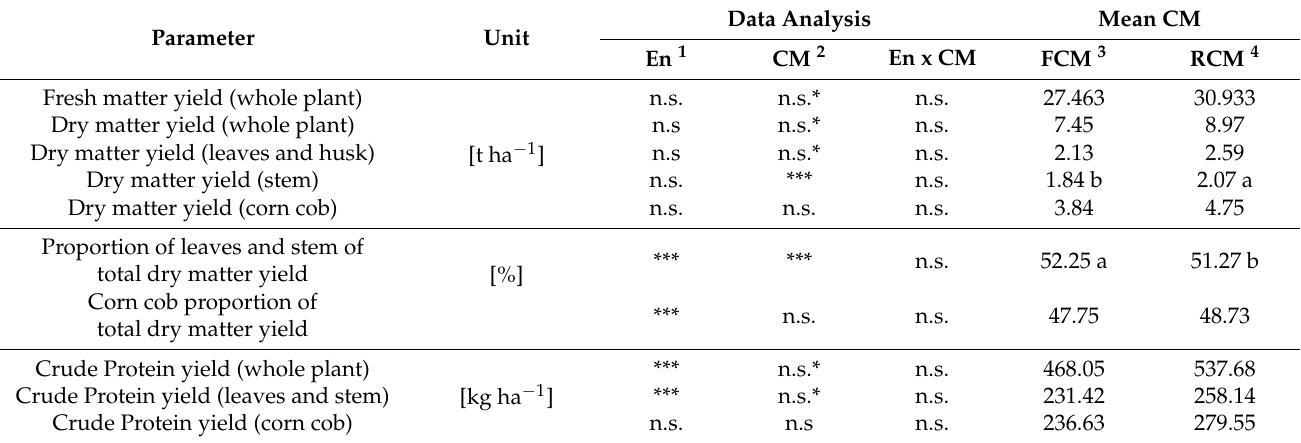
Table 4. Results of a multiple comparison statistical analysis of maize crop yield.